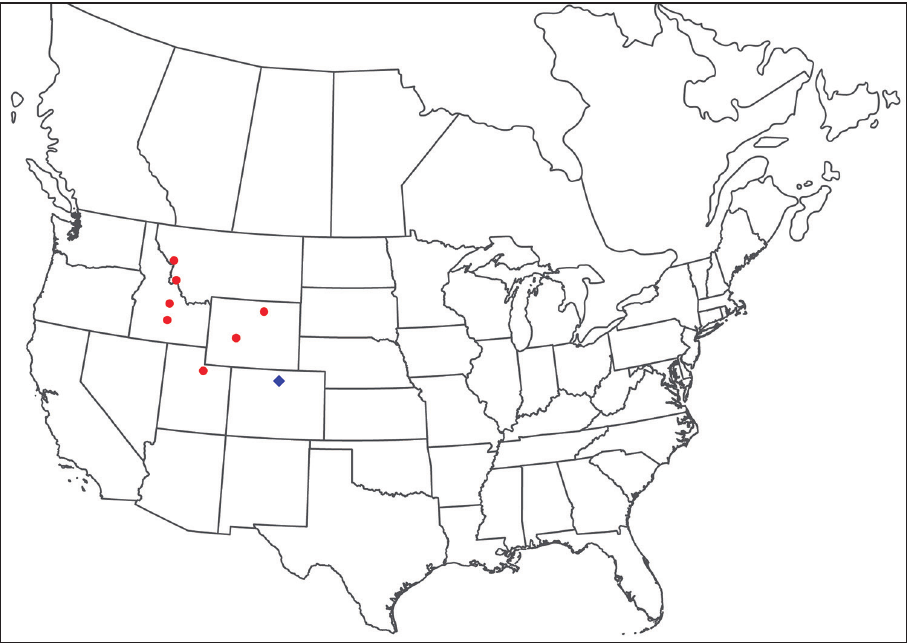
Figure 155. Torrenticola mulleni sp. n. distribution. Red dots represent material examined. Blue dot represents previously-published record (Young 1969), reported as T. indistincta , but likely representing T. mulleni